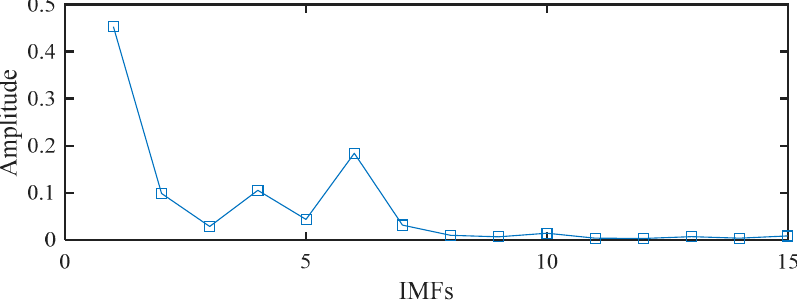
Figure 7. The weighted average coefficients using Teager energy kurtosis (TEK).